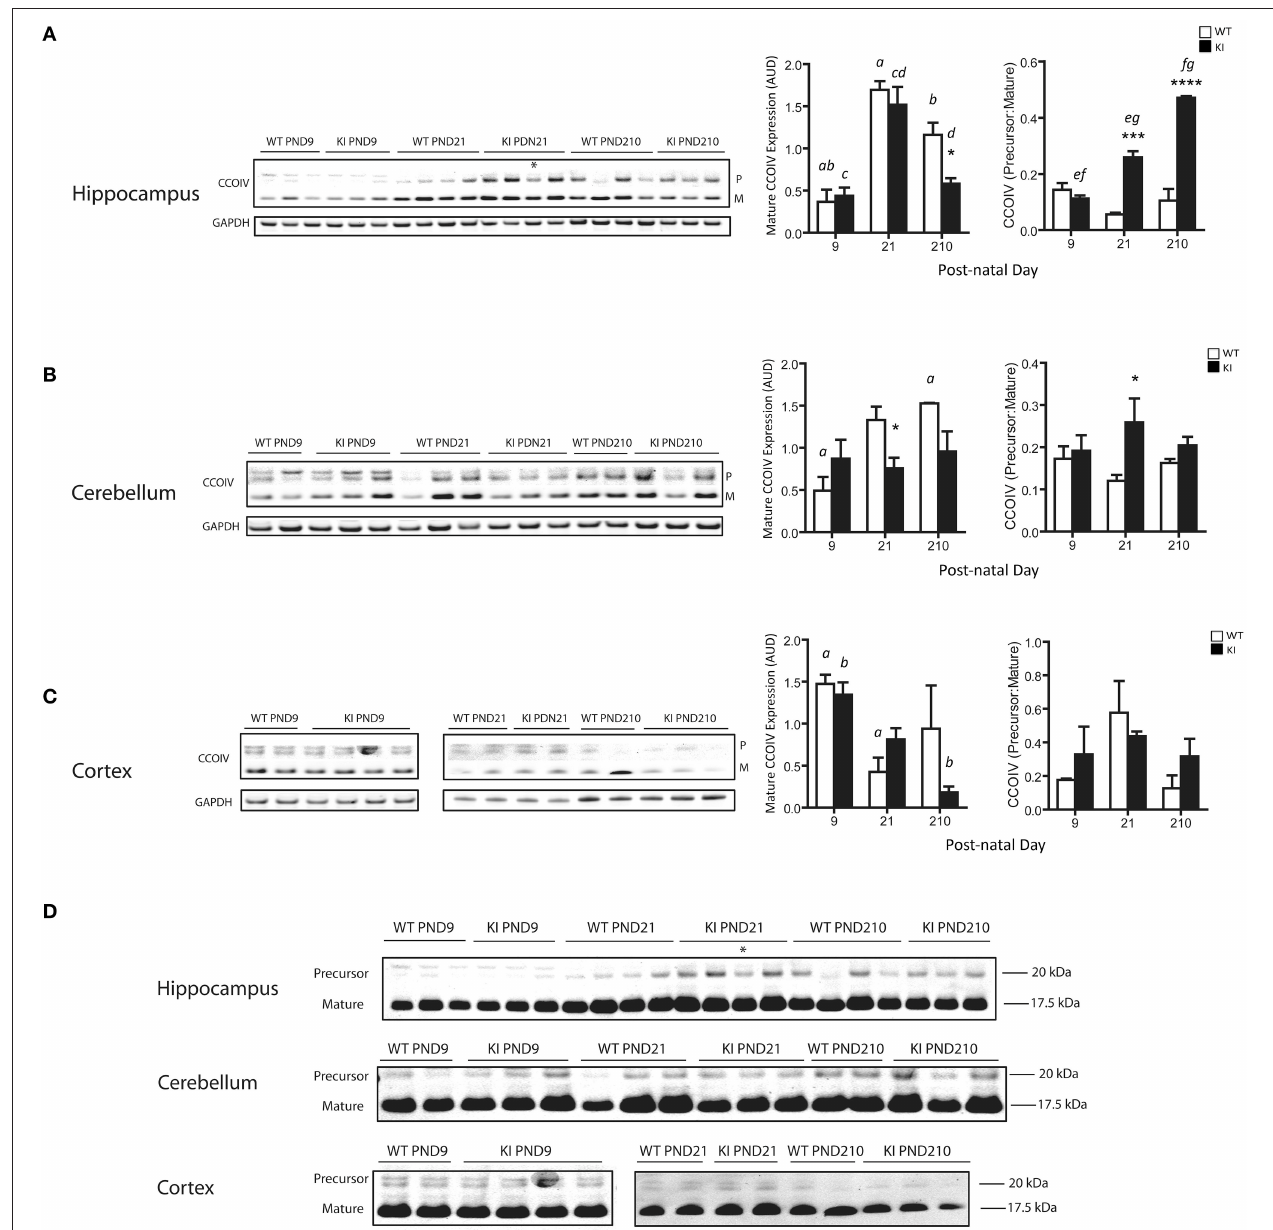
FIGURE 5 | Protein expression of precursor and mature CCOIV in brains from KI mice. Representative Western blots of CCOIV (precursor and mature proteins) in hippocampus (A) , cerebellum (B) and cortex (C) of WT and KI mice. The densitometry for all the samples is also shown. Data were expressed as Arbitrary Densitometry Units and reported as mean ± SEM. Mature form of CCO4 was normalized by GAPDH. Data are reported as mean ± SEM, n = 3–5 per genotype per time point, ran in triplicates. Statistical analysis was performed by Two-way ANOVA, followed by Tukey post-hoc test for multiple comparisons. Statistically significant differences between WT and KI are indicated by asterisks as follows. Hippocampus: * p = 0.0416; *** p = 0.0002; **** p < 0.0001. Cerebellum: * p = 0.0212 for mature CCO at PND21; * p = 0.0197 for P:M at PND21. Statistically significant differences among time points are indicated by letters as follows. Hippocampus: p = 0.0002 ( a ), p = 0.0172 ( b ), p = 0.0013 ( c ), p = 0.0047 ( d ), p = 0.0086 ( e ), p < 0.0001 ( f ), p = 0.0003 ( g ). Cerebellum: p = 0.0459 ( a ). Cortex: p = 0.0391 ( a ), p = 0.0113 ( b ). Further statistical details on the genotype, age, and genotype × age effect can be found in Table 3 . (D) Uncropped version of the Western blot image showing the intensity and mobility of the precursor band relative to the mature protein. The observed molecular weights for the CCOIV precursor and mature forms were, respectively, 20.0 and 17.5 kDa, as extrapolated by the Molecular Weight markers with the use of the Carestream software. This 2.5 kDa difference was close to the theoretical calculated molecular weight (2.4 kDa) of the 22 residues of amino acids (MLATRVFSLVGKRAISTSVCVR) present in the precursor form, which is cleaved by mitochondrial matrix peptidases (Isaya et al., 1991) to produce the mature mitochondrial form of the protein (UniProtKB P13073). Asterisk in the immunoblot image of hippocampus (panels A and D) denotes a 90 CGG KI sample. Densitometry data for this sample have not been included in the averages for KI. For cortex, samples were run in two separate gels (PND9 and PND21-210). AUD, Arbitrary Units of Densitometry.